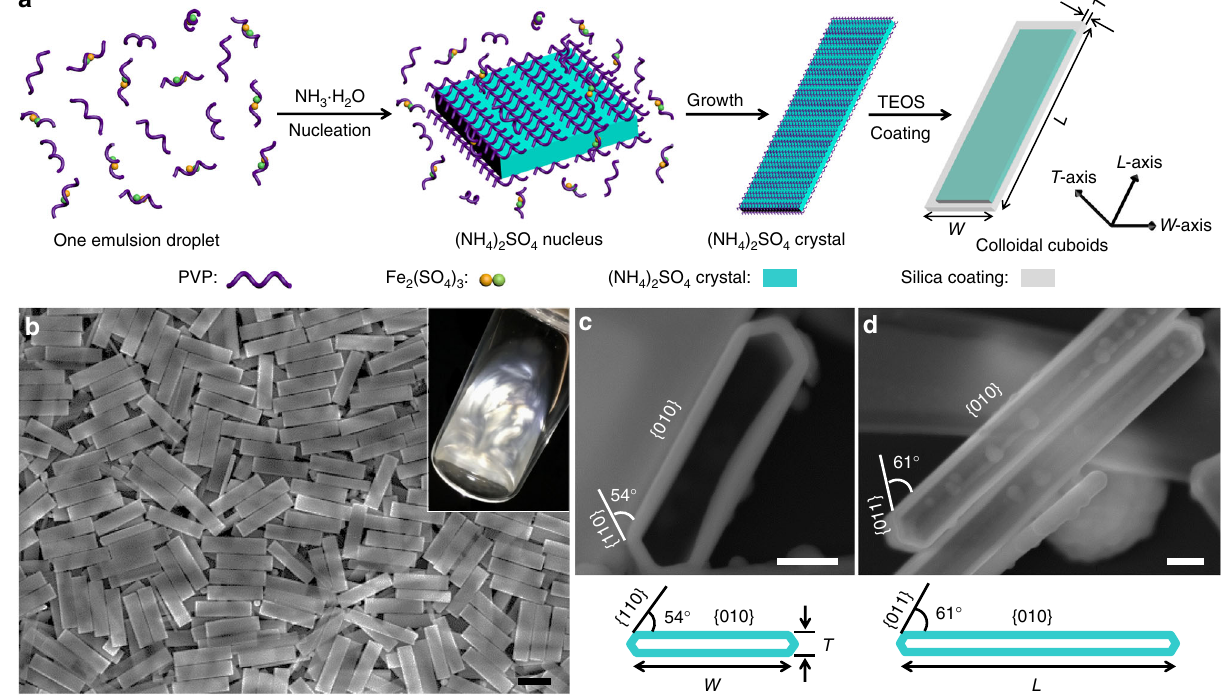
Fig. 1 Schematic illustration of the synthesis and structure of colloidal cuboids. a Schematics illustrating the synthesis of colloidal cuboids based on (NH 4 ) 2 SO 4 crystal-templated hydrolysis of silica precursors. b SEM image of representative monodisperse cuboidal particles ( L = 3600nm, W = 870 nm, T = 220 nm). Inset photo shows the birefringence of a suspension of 0.2 wt% colloids in ethanol upon shaking (taken between cross-polarizers). c , d SEM images of cuboidal particles after removal of (NH 4 ) 2 SO 4 core: c top view of a fractured cuboid with an open silica shell and d side view of intact cuboids with closed silica shell. Bottom schematics illustrate the corresponding facets of (NH 4 ) 2 SO 4 crystal. Scale bars, 2 μ m in ( b ) and 200 nm in ( c , d )